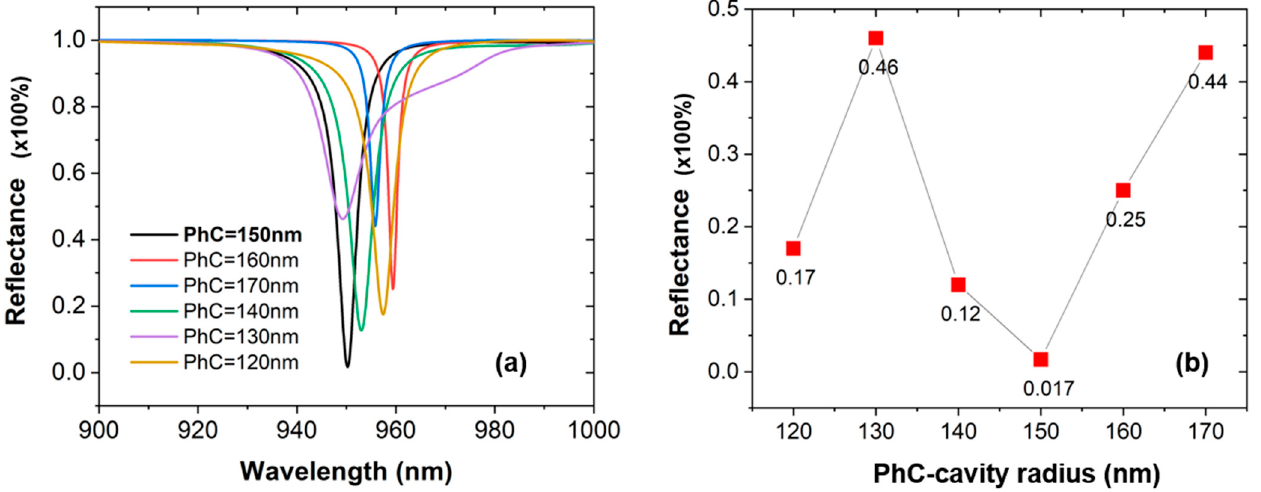
Figure 2. ( a ) Values of the radii of the PhC-cavity for the optimization of the sensor. ( b ) Output spectra showing a drop in the reflectance of the sensor with respect to the change in the PhC-cavity radius.